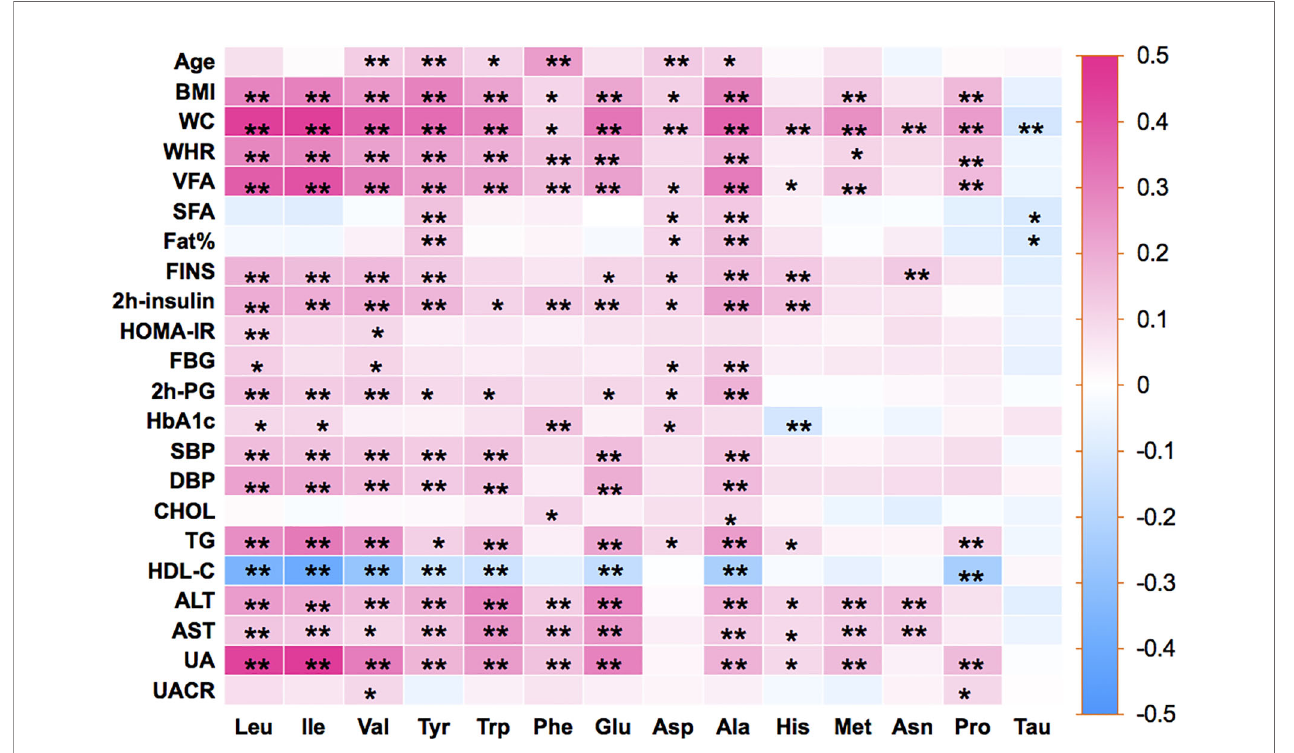
FIGURE 1 | Pearson ’ s correlation coef fi cients were calculated between 14 amino acids and metabolic-related variables. BMI, body mass index; WC, waist circumference; WHR, waist-to-hip ratio; Fat%, body fat percentage; VFA, visceral fat area; SFA, subcutaneous fat area; FINS, fasting serum insulin; HOMA-IR, homeostasis model assessment for insulin resistance; FPG, fasting blood glucose; 2h-PG, 2-h postprandial glucose; HbA1c, glycosylated hemoglobin A1c; SBP, systolic blood pressure; DBP, diastolic blood pressure; TC, total cholesterol; TG, triglyceride; HDL-c, high-density lipoprotein-cholesterol; ALT, alanine aminotransferase; AST, aspartate aminotransferase; UA, uric acid; UACR, urine albumin-to-creatinine ratio; Ile, isoleucine; Leu, leucine; Val, valine; Tyr, tyrosine; Trp, tryptophan; Phe, phenylalanine; Glu, glutamic; Asp, aspartic; Ala, alanine; His, histidine; Met, methionine; Asn, asparagine; Pro, proline; Tau, taurine. Statistical differences between 14 amino acids and metabolic-related variables are shown as *P < 0.05 and ** P <